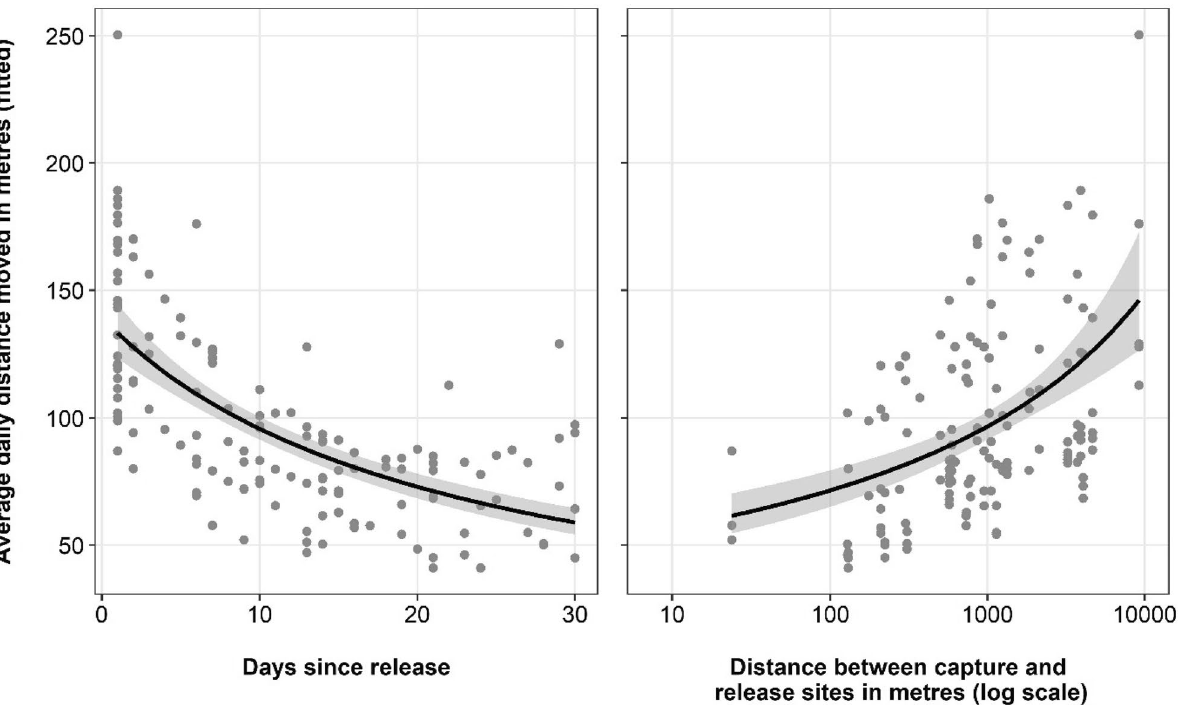
Figure 3. Relationships between days since release and distance between capture and release sites on fitted average daily distance moved by koalas from model-averaging of the top (∆AIC ≤ 2) generalised linear mixed models.